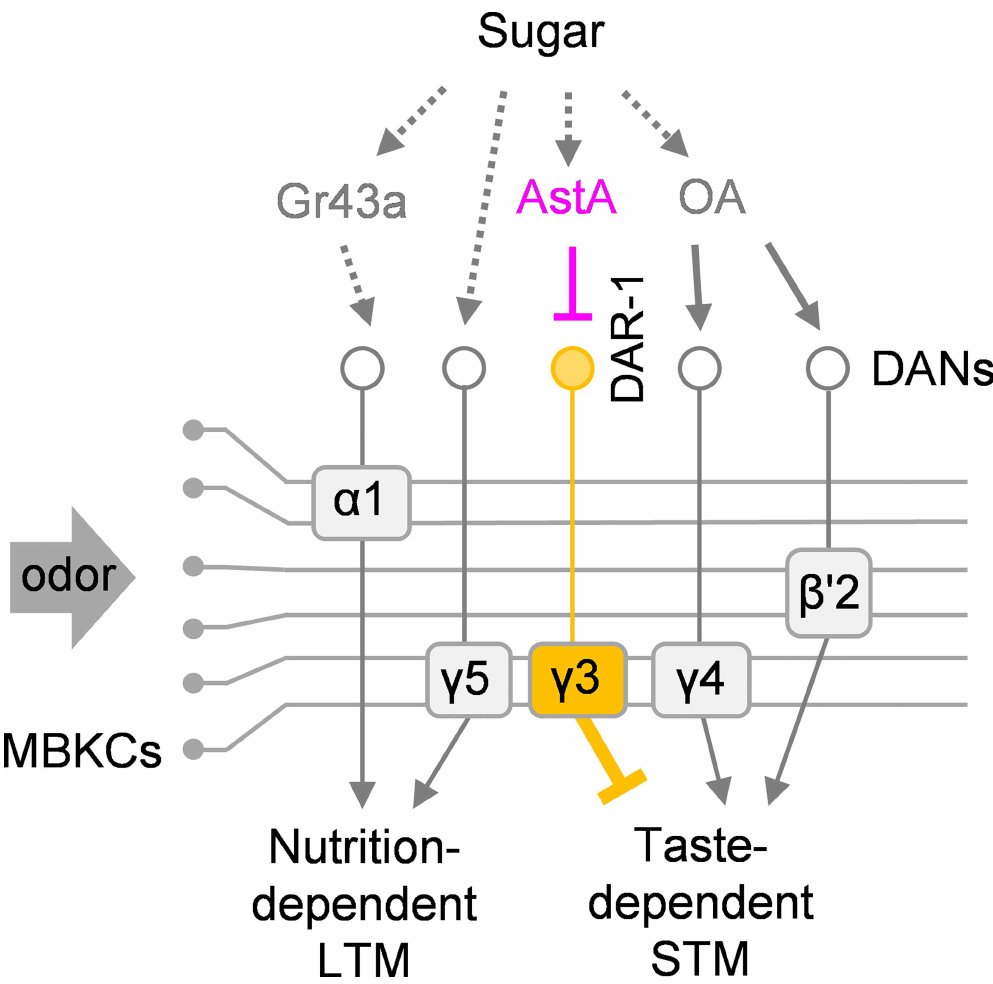
Fig 11. Reward signals by excitation and inhibition of dopamine neurons. Schematic diagram of the reward circuits in the MB. Sugar ingestionactivates multiplemodulatorypathways, such as octopamine and AstA, that bidirectionally regulatedistinct dopamine neurons. These dopamine neuronsconvey rewardsignals to the MB by their activationor inhibition and induce appetitivememory.